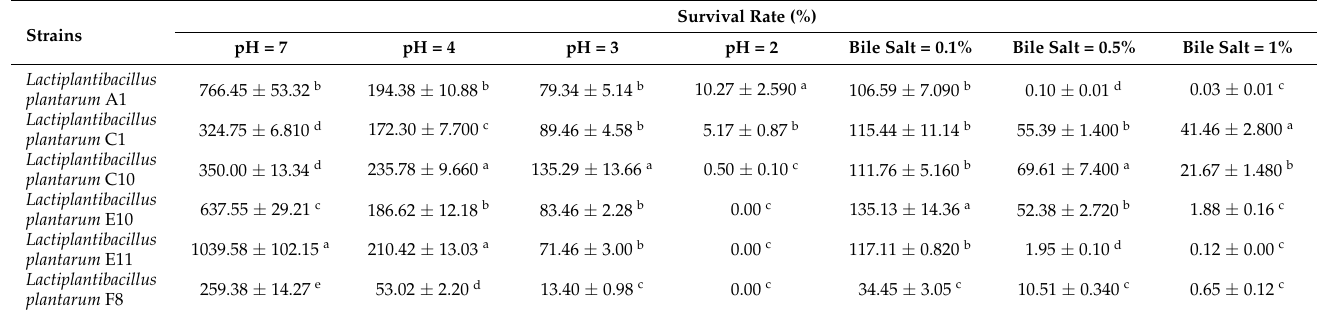
Table 6. Survivability of the LAB strains in acidic pH and bile salts.